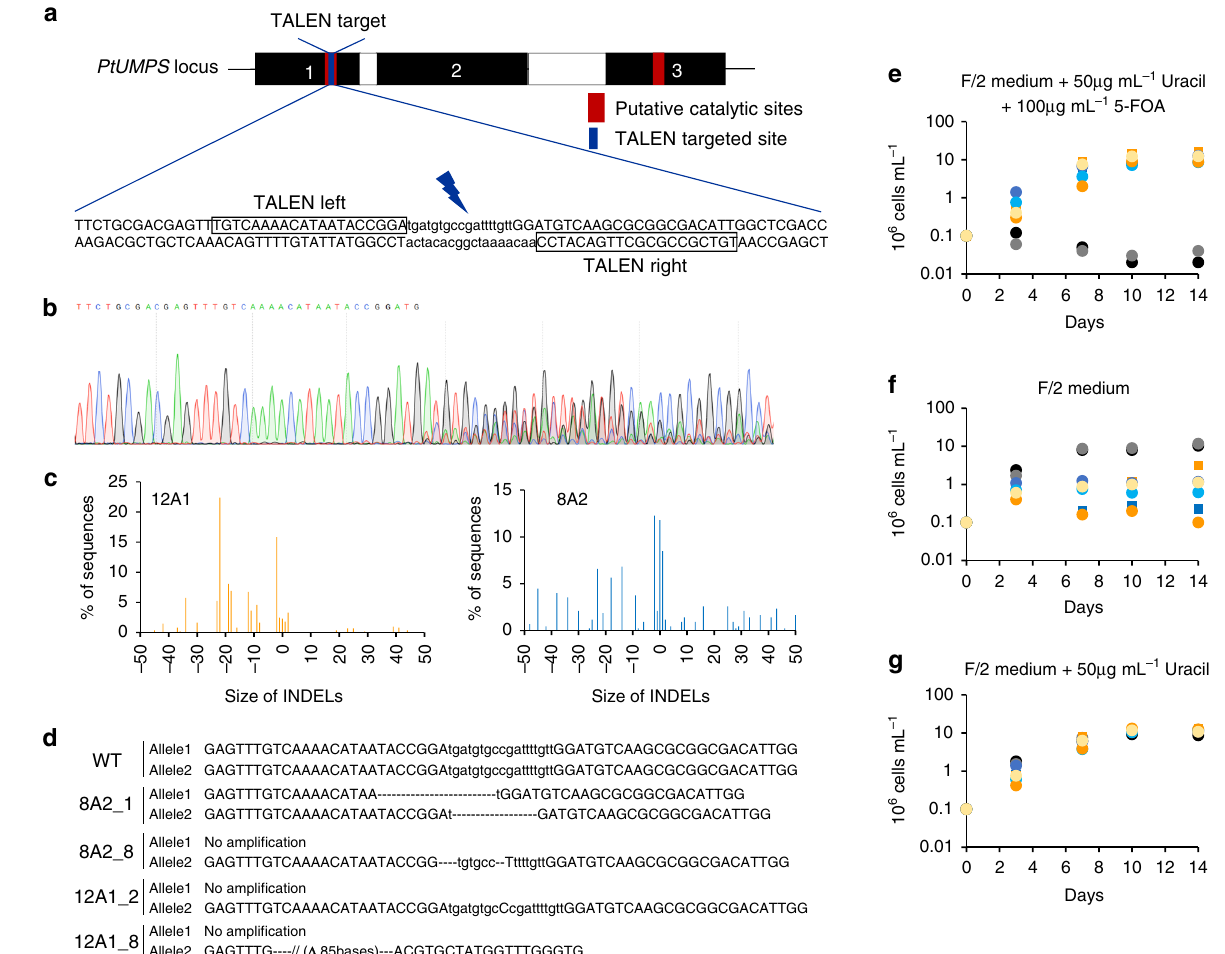
Fig. 1 Characterization of PtUMPS knock-out strains generated using a TALE nuclease. a Structure of the PtUMPS locus. The exons are represented as black boxes, with the putative catalytic sites in red and the TALEN-targeted site in blue. The half-sites recognized by each TALEN are boxed. b Sequence chromatogram of a PCR product ampli fi ed from strain 12A1, showing the presence of heterogeneous sequences surrounding the TALEN cutting site. c INDEL spectrum and frequency predicted by the Track INDELs by DEcomposition (TIDE) algorithm in the two 5-FOA-resistant colonies, 8A2 and 12A1. d Example of mutagenic events through the alignment of the wild type and 8A2_1, 8A2_8, 12A1_2, and 12A1_8 subclones DNA sequences at the PtUMPS locus. e – g Representative growth experiments from two independent repeats performed over 14 days with the parental NCMA strain (black circles), the 2A3 control strain transformed with the NAT vector only (gray circles), two 5-FOA-resistant populations (8A2 dark blue squares and 12A1 dark orange squares), and four subclones: 8A2_1 (dark blue circles), 8A2_8 (light blue circles), 12A1_2 (dark orange circles) and 12A1_8 (yellow circles), e F/2 medium supplemented with 50 µ g mL − 1 uracil and 100 µ g mL − 1 5-FOA, f classical F/2 medium, or g F/2 supplemented with 50 µ g mL − 1 uracil. Y-axis e – g presents cell density, expressed as million cells per mL, on a logarithmic